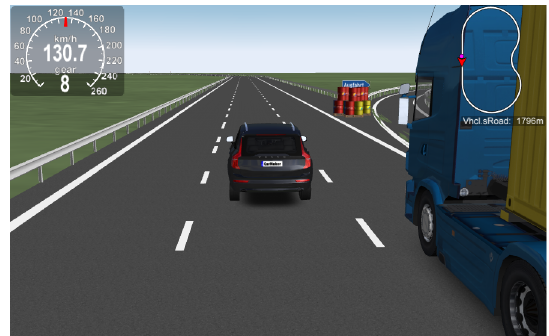
Figure 3. Snapshot of the junction, exit sign, and impact attenuating barrels.